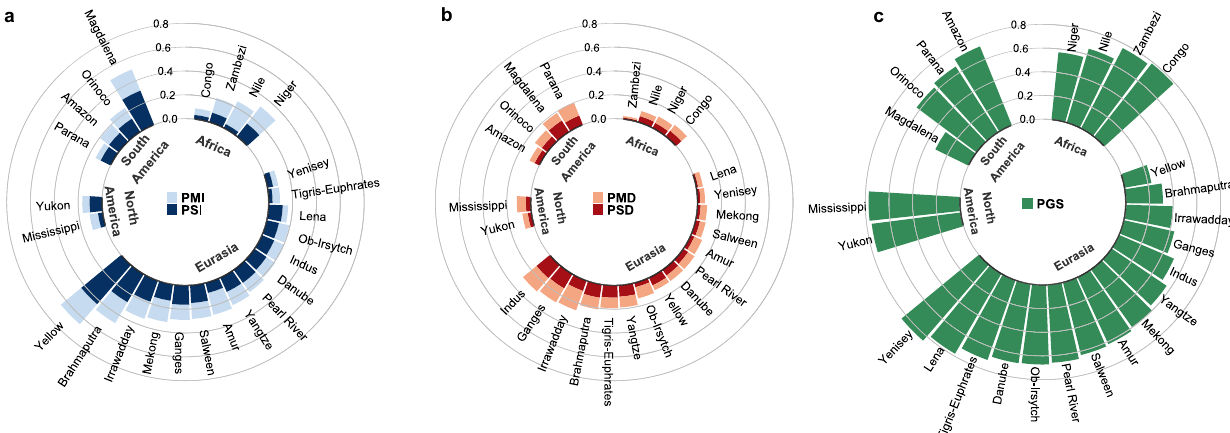
Fig. 4 | Water extent changes in 25 mega river basins. a the percentage of increase (PI). b the percentage of decrease (PD). c the percentage of general stable river areas (PGS).